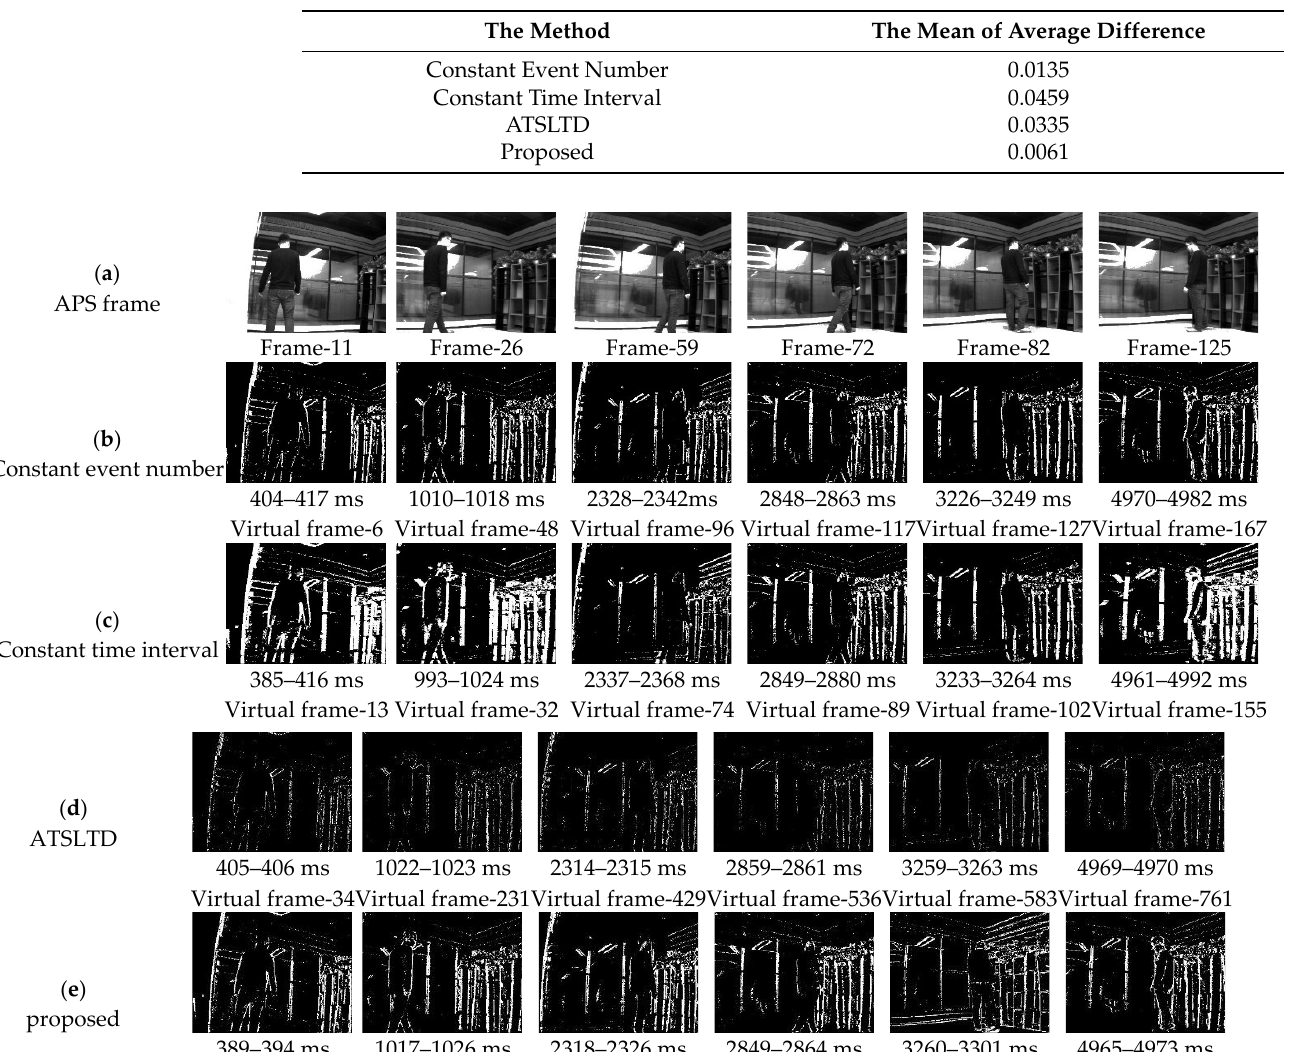
Table 2. The mean value of the difference between the information entropy of virtual frame obtained by the four methods and APS frame.